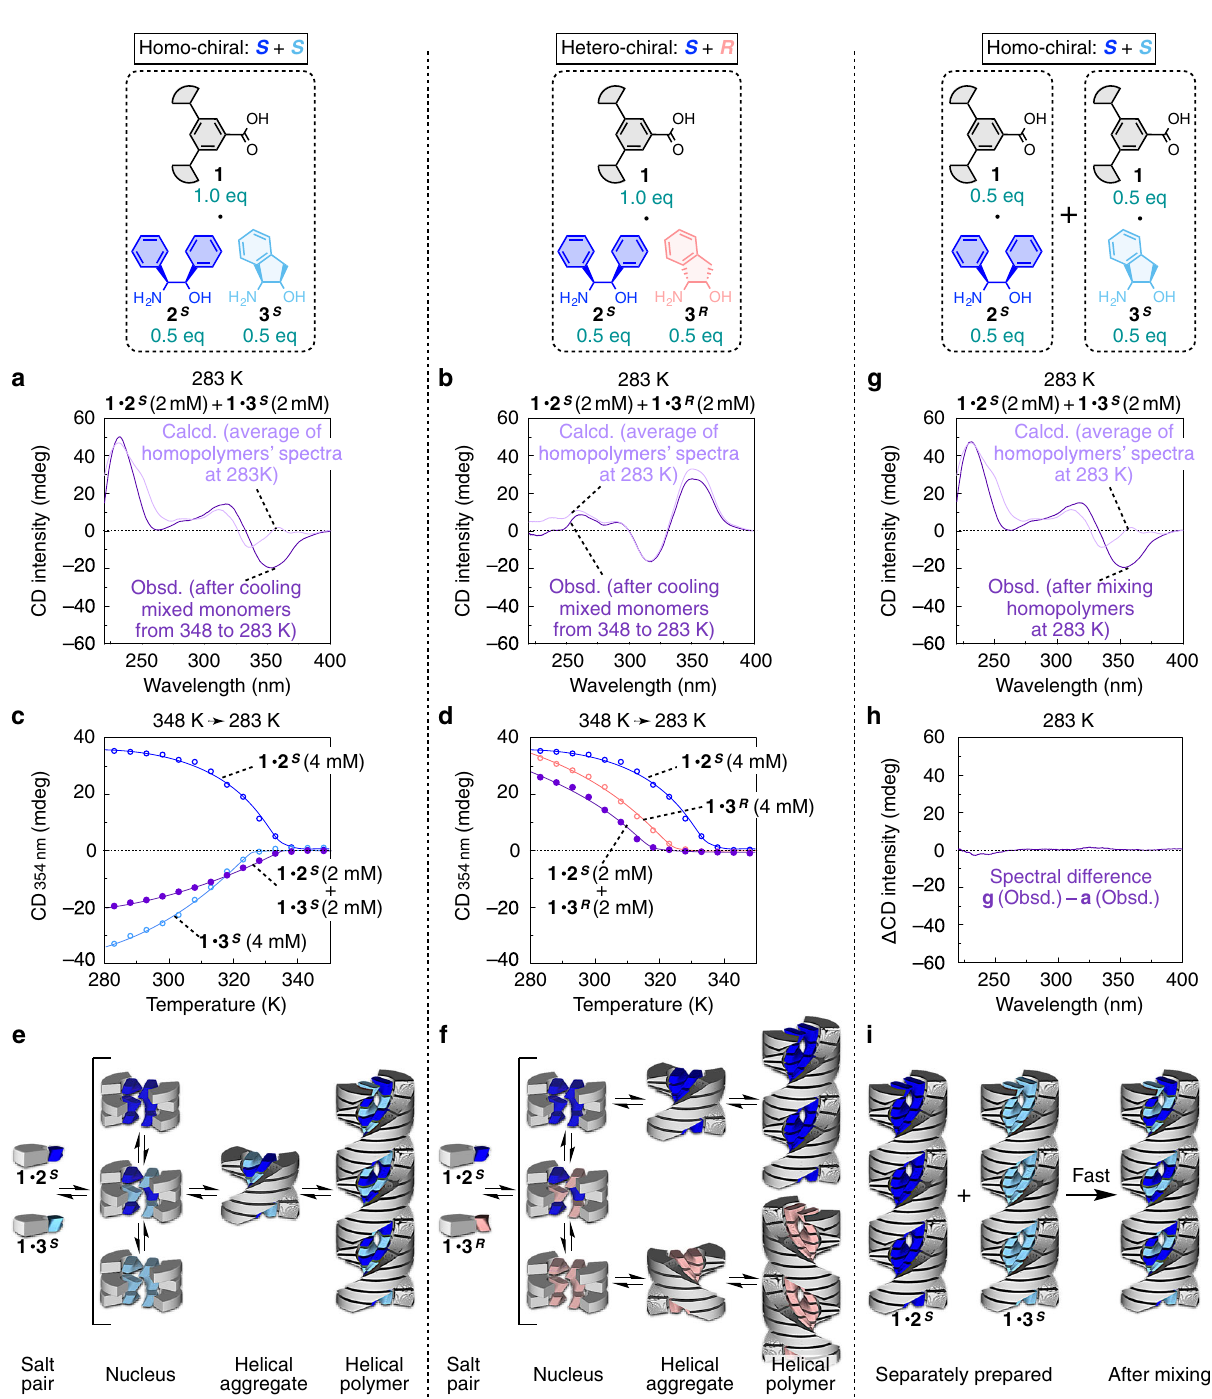
Fig. 5 Stereoselective supramolecular copolymerization of two kinds of monomers. a Obsd.: CD spectrum of a mixture of 1 ∙ 2 S and 1 ∙ 3 S in dodecane ([ 1 ∙ 2 S ] = [ 1 ∙ 3 S ] = 2.0 mM) after cooling from 348 to 283 K at − 1.0 K/min. Calcd.: average of the CD spectra of 1 ∙ 2 S in dodecane (4.0 mM) and 1 ∙ 3 S in dodecane (4.0 mM) separately measured at 283 K. b Obsd.: CD spectrum of a mixture of 1 ∙ 2 S and 1 ∙ 3 R in dodecane ([ 1 ∙ 2 S ] = [ 1 ∙ 3 R ] = 2.0 mM) after cooling from 348 to 283 K at − 1.0 K/min. Calcd.: average of the CD spectra of 1 (cid:129) 2 S in dodecane (4.0 mM) and 1 ∙ 3 R in dodecane (4.0 mM) separately measured at 283 K. c Cooling curves (from 348 to 283 K at – 1.0 K/min, monitored with CD intensity at 354 nm) of a mixture of 1 ∙ 2 S and 1 ∙ 3 S in dodecane ([ 1 ∙ 2 S ] = [ 1 ∙ 3 S ] = 2.0 mM), 1 ∙ 2 S in dodecane (4.0 mM), and 1 ∙ 3 S in dodecane (4.0 mM). d Cooling curves (from 348 to 283 K at − 1.0 K/min, monitored with CD intensity at 354 nm) of a mixture of 1 ∙ 2 S and 1 ∙ 3 R in dodecane ([ 1 ∙ 2 S ] = [ 1 ∙ 3 R ] = 2.0 mM), 1 ∙ 2 S in dodecane (4.0 mM), and 1 ∙ 3 R in dodecane (4.0 mM). e , f Schematics for the supramolecular polymerization of the homo-chiral ( 1 ∙ 2 S and 1 ∙ 3 S ; e ) and hetero-chiral ( 1 ∙ 2 S and 1 ∙ 3 R ; f ) mixtures. g Obsd.: CD spectrum of an equi-volume mixture of 1 ∙ 2 S in dodecane (4.0 mM, before mixing) and 1 ∙ 3 S in dodecane (4.0 mM, before mixing) measured 30 s after mixing at 283 K. Calcd.: average of the CD spectra of 1 ∙ 2 S in dodecane (4.0 mM) and 1 ∙ 3 S in dodecane (4.0 mM) separately measured at 283 K. h Differential spectrum between the mixtures of 1 ∙ 2 S and 1 ∙ 3 S in a and g . i Schematic for merging of the supramolecular polymers of 1 ∙ 2 S and 1 ∙ 3 S